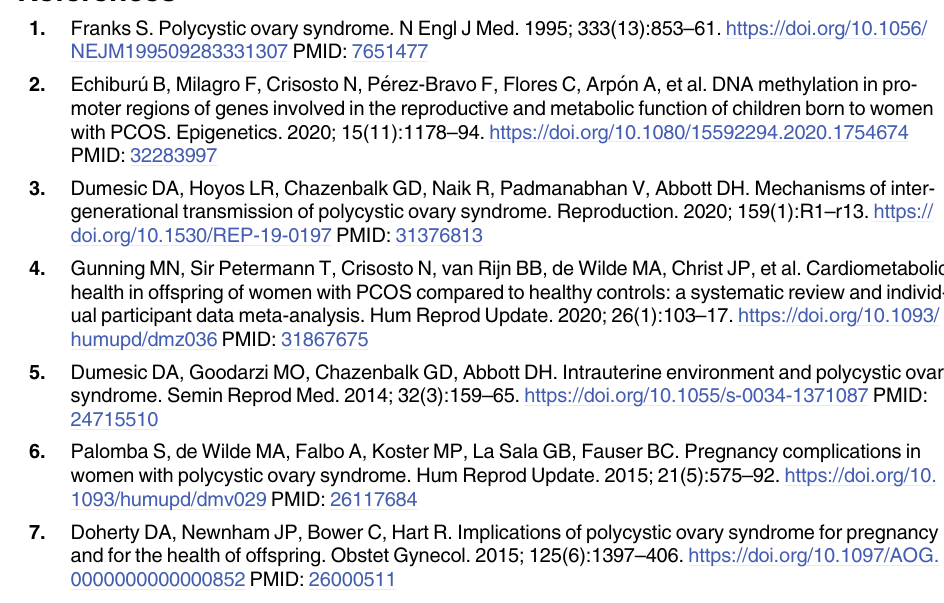
S5 Table. Effect of maternal PCOS on steroid hormones in children, unadjusted, and adjusted for children BMI z-score. S6 Table. Metformin effect on steroid hormones in children from the PregMet study, unadjusted, and adjusted for BMI